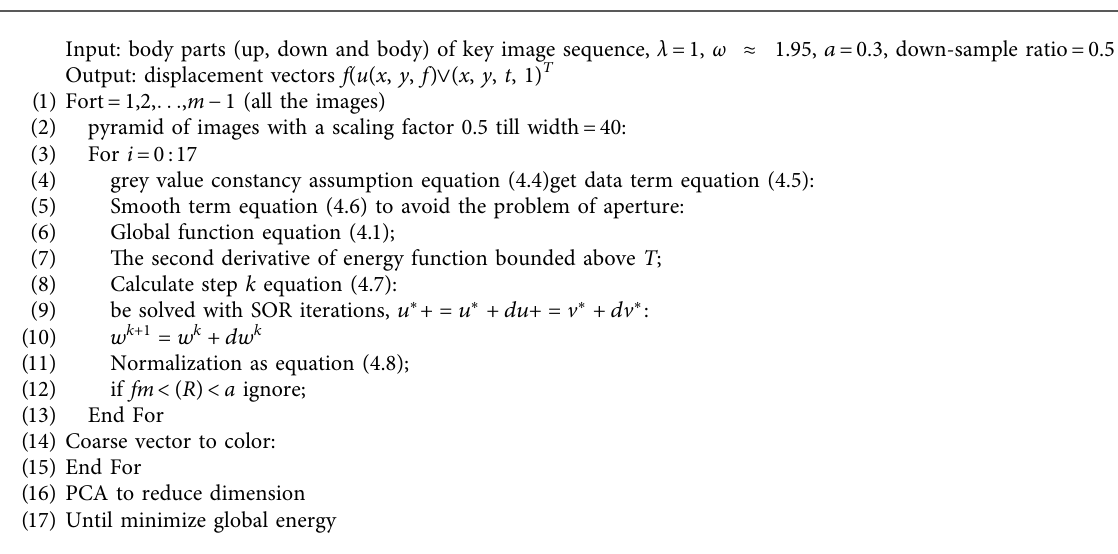
A LGORITHM 1: Optical flow feature extraction